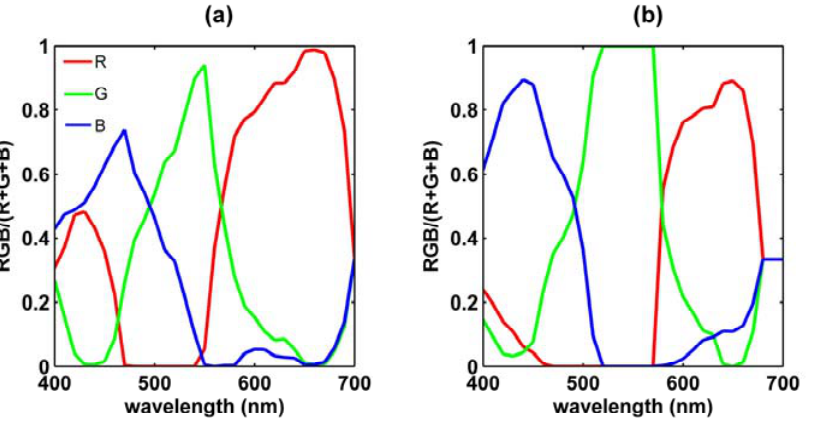
Figure 3. Response spectra of (a) CP885, and (b) ECOshot digital cameras. Response was defined as RGB values in bits, normalized to their total. Camera settings were auto exposure mode using Exp. +/- = 0 eV, and white balance ‘Direct Sunlight’.